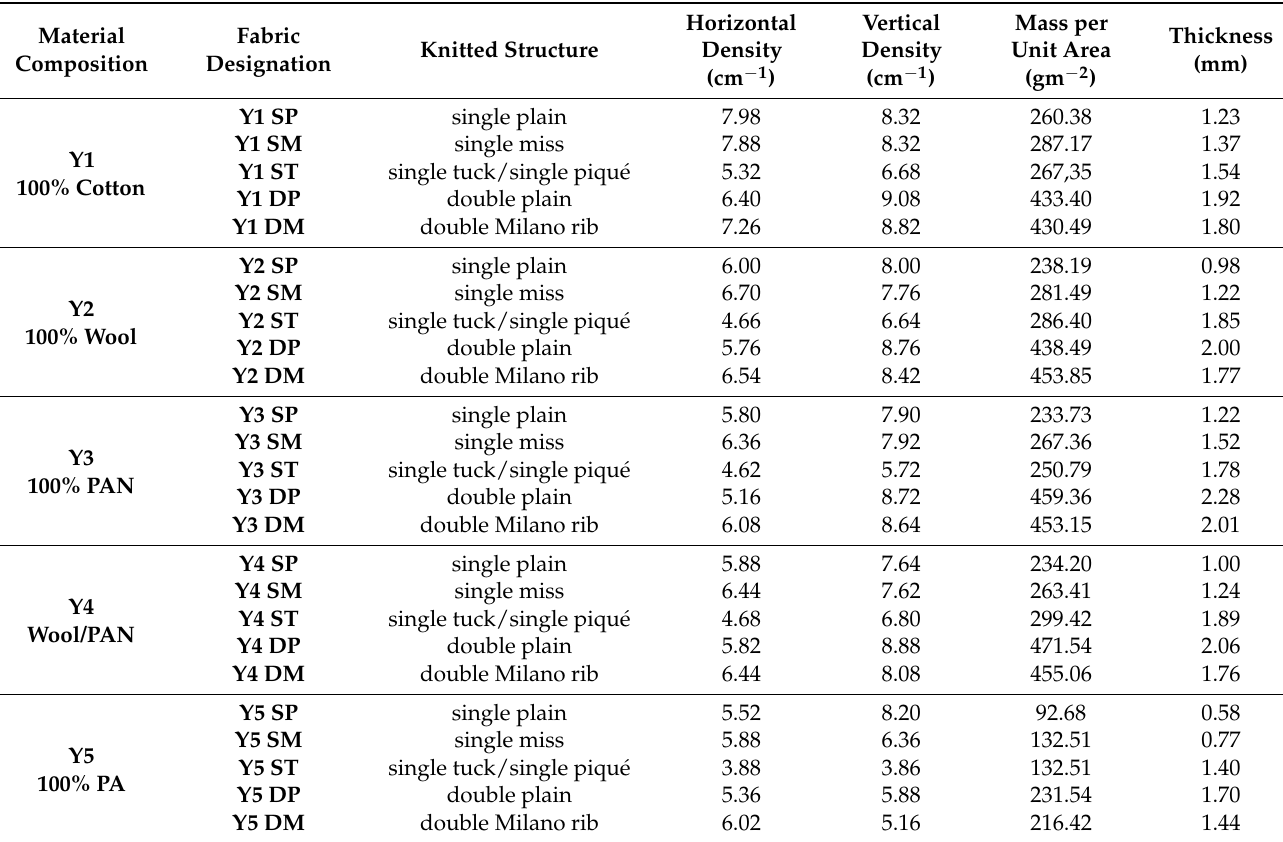
Table 4. Knitted samples designation and structural properties.